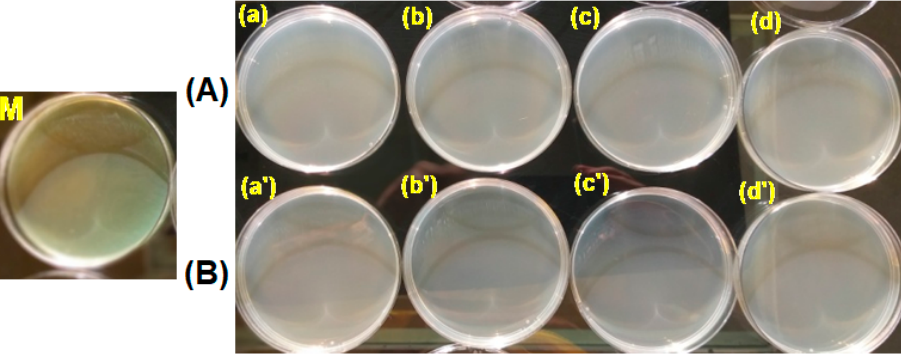
Figure 14. Antimicrobial activity of PSFEtP + polysulfone at different concentrations: C 1 ( a , a’ ), C 2